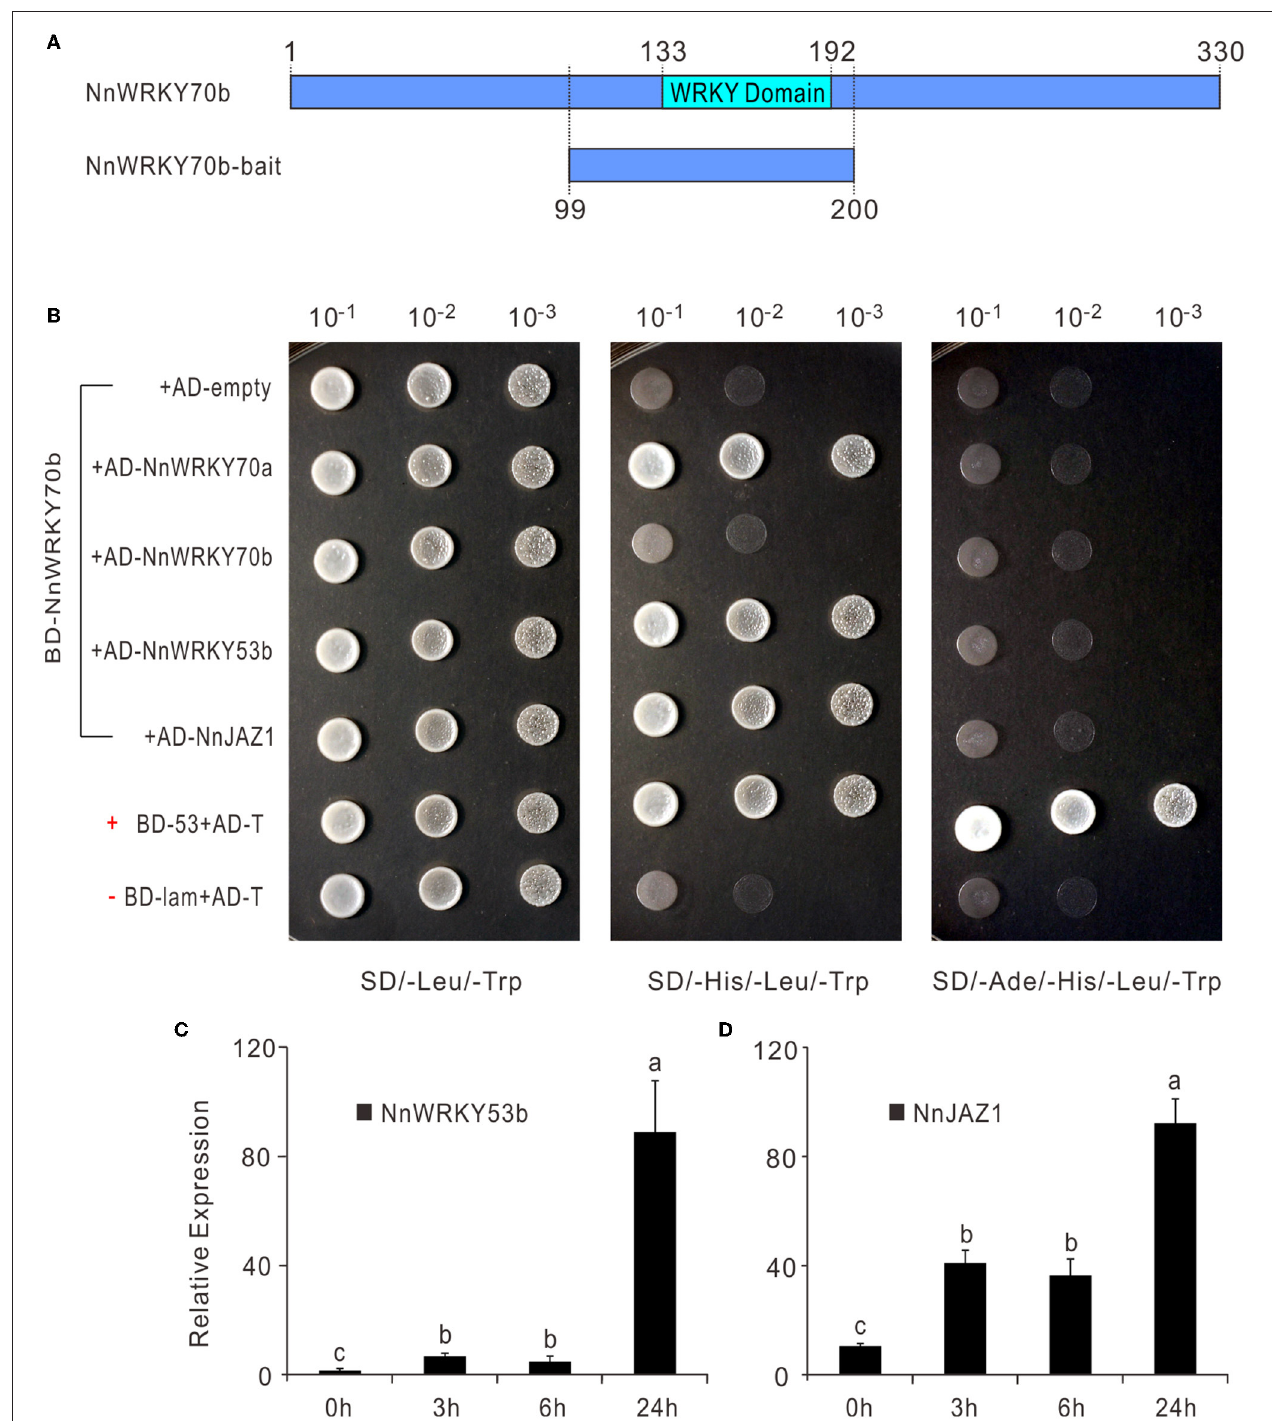
FIGURE 6 | NnWRKY70b regulates the lotus BIA biosynthesis by interacting with NnWRKY70a, NnWRKY53b, and NnJAZ1 proteins. (A) Schematic showing the truncated NnWRKY70b bait used in the yeast two-hybrid assay. (B) Yeast two-hybrid assay showing the interaction between NnWRKY70b and other proteins. AD and BD represent the two yeast vectors of pGADT7 and pGBKT7, respectively. Control vectors BD-53 and BD-lam carry the murine p53 and the lamin respectively, while AD-T carries SV40 larger T-antigen. p53 and T-antigen are known to interact in the yeast two-hybrid assay. Thus, a combination of BD-53 + AD-T was used as a positive control, while the un-interactional BD-Lam + AD-T was set as a negative control. (C,D) Expression of NnWRKY53b and NnJAZ1 in response to MeJA treatment. MeJA treatment was conducted in lotus leaves at the developmental stage 4. Data are means ± SE ( n = 3). Lower case letters represent significant differences at P <